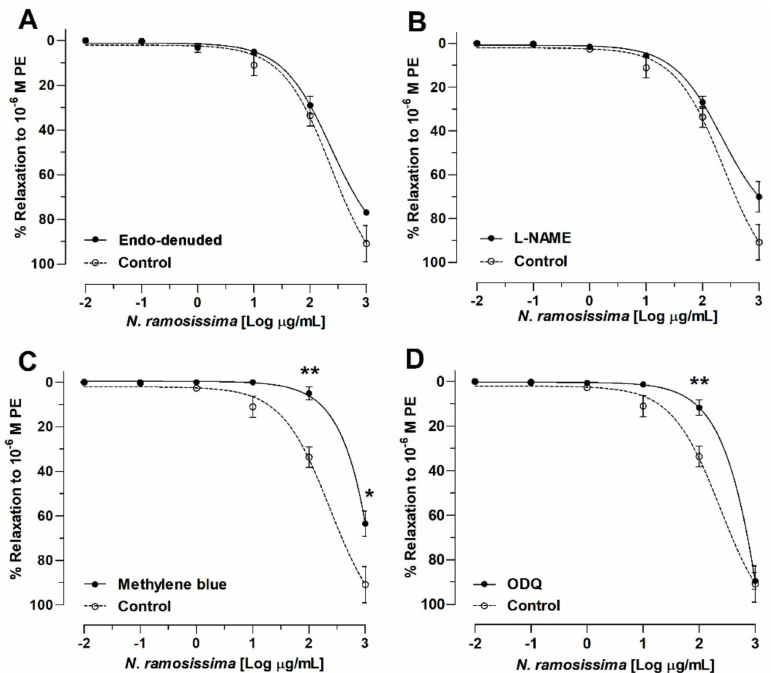
Figure 7. Relaxation e ff ect of N. ramosissima in rat aorta. Arteries were pre-contracted with 10 − 6 M PE. Concentration-response curves for N. ramosissima extract in intact and denuded-endothelium aortic rings ( A ) in absence (Control) or in presence of 10 − 4 M L-NAME ( B ), 10 − 6 M methylene blue ( C ) or 10 − 6 M 1H-(1,2,4) oxadiazolo [4 ,3-a]quinoxalin-1-one (ODQ) ( D ) in rat aorta. Methylene blue and ODQ are non-selective and selective inhibitors of soluble guanylyl cyclase, respectively. Data are the average ± standard error of the mean (SEM) of 5 independent experiments. * p < 0.05, ** p < 0.01 vs.